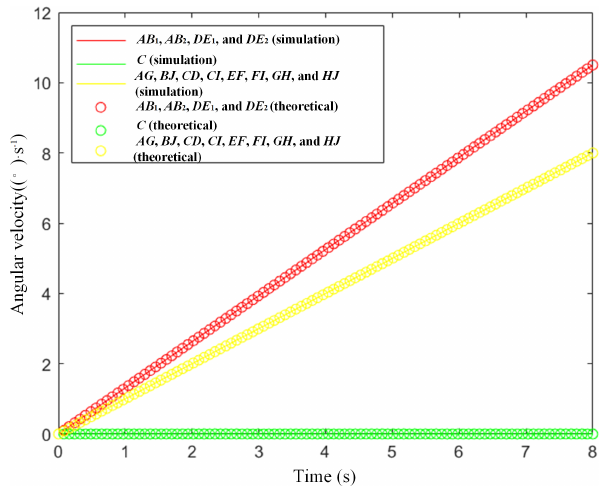
Figure 18. Angular acceleration of each